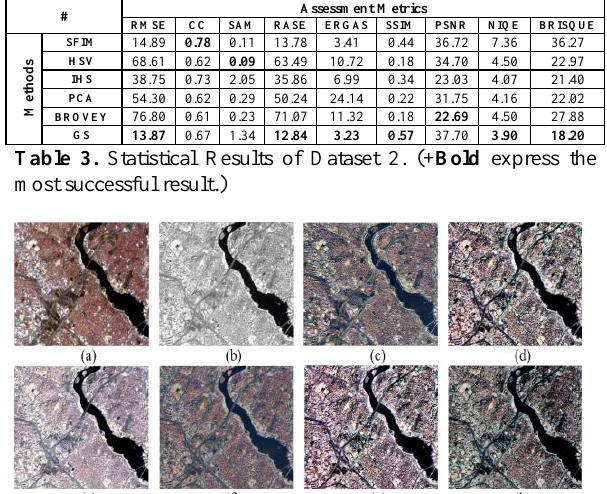
Figure 3. Qualitative results of Rasat dataset a) MS, b) PAN, c) SFIM, d) HSV, e) IHS, f) PCA, g) BORVEY, and h) GS